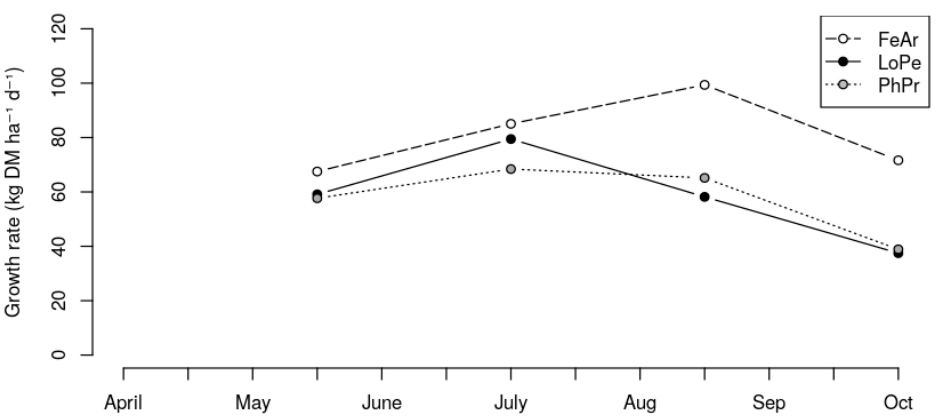
Lolium perenne , PhPr : Phleum pratense ; averaged over years and sites. Figure 2. Combined regime: Growth rates (kg DM ha − 1 d − 1 ) of FeAr: Festuca arundinacea, LoPe: Lolium